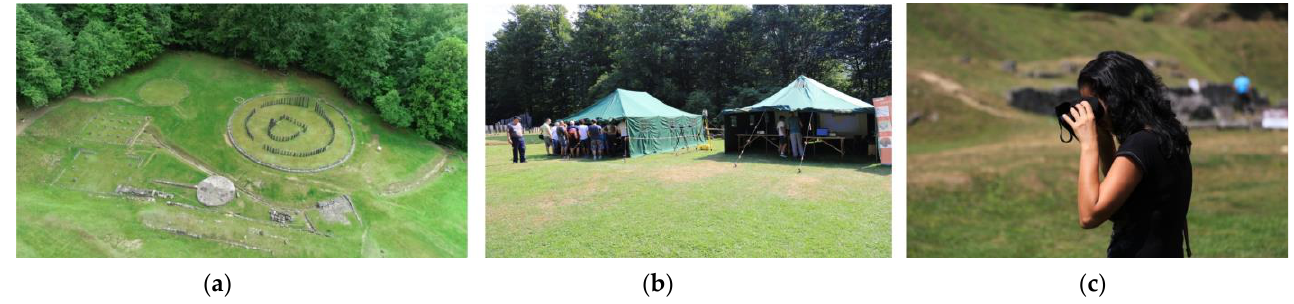
Figure 23. ( a ) Aerial view of the Sarmizegetusa Regia Sacred Area; ( b ) The two large tents used at the Open Day Event; ( c ) Visitor using an HMD system at the event.